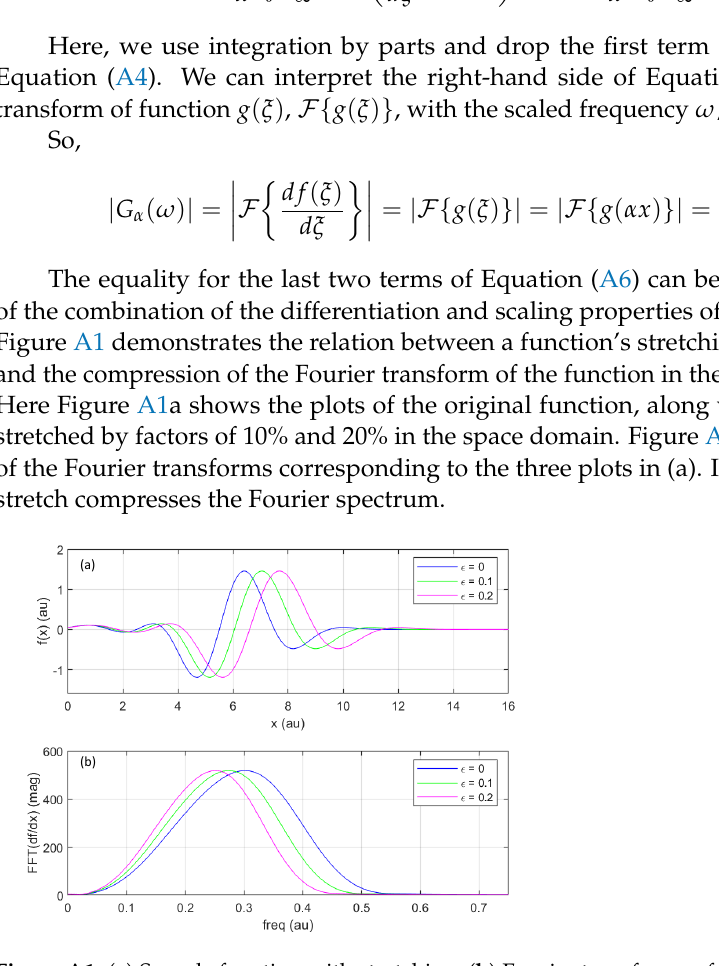
Figure A1. ( a ) Sample function with stretching, ( b ) Fourier transforms of functions in ( a